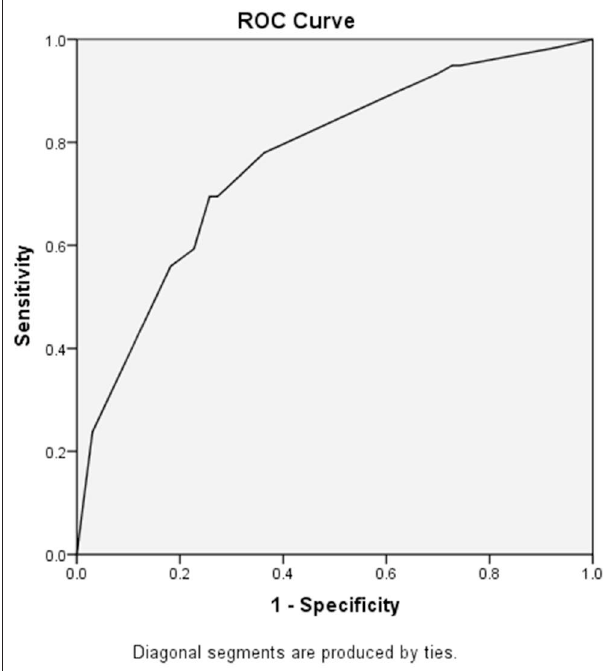
FIGURE 2 | ROC curve of the multivariable model in the prediction of delayed discharge. The area under the ROC was 0.766 for retained variables in the multivariable model. With this multivariable model, more than three-quarters of the patients discharged ≥ 14 days could be classified